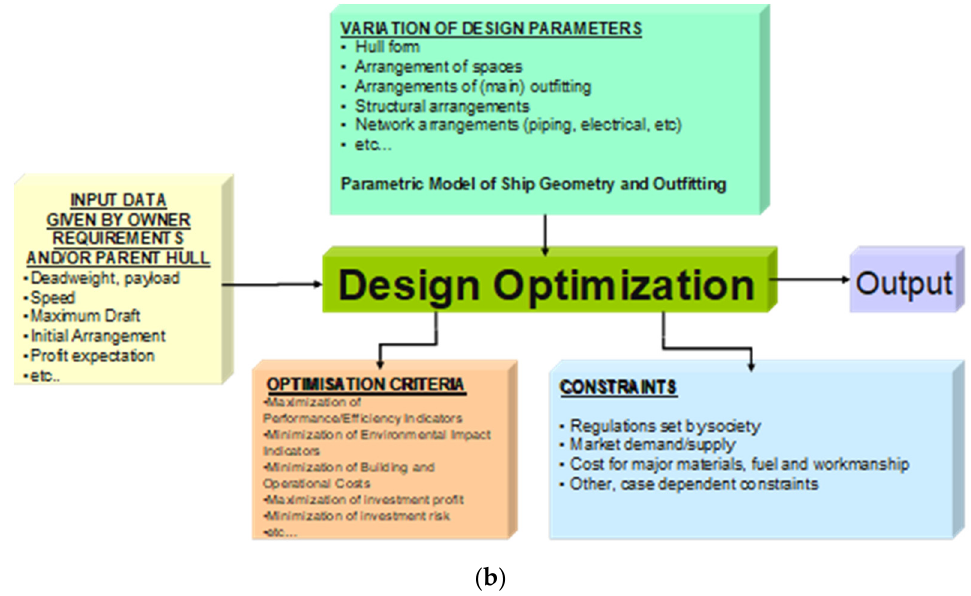
Figure 7. ( a ) Ship Design from Single- to Multi-Objective Optimization [16]. ( b ) Ship Design from Single- to Multi-Objective Optimization [1].